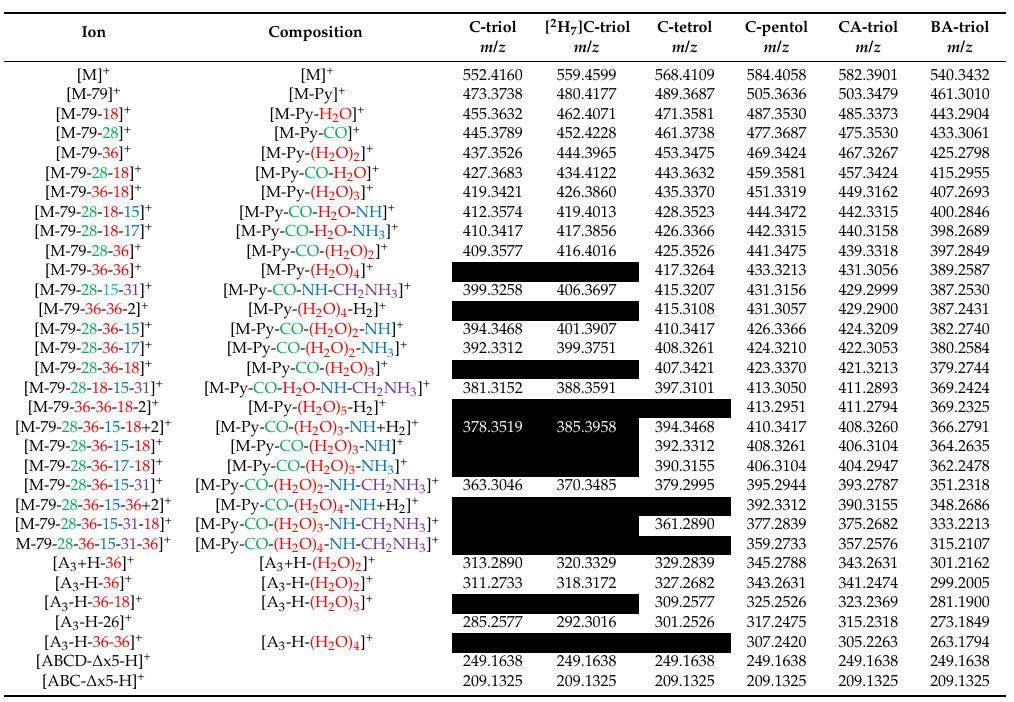
Table 1. Composition of fragment ions generated from oxidised/GP-derivatised C 27 bile alcohols and C 27 and C 24